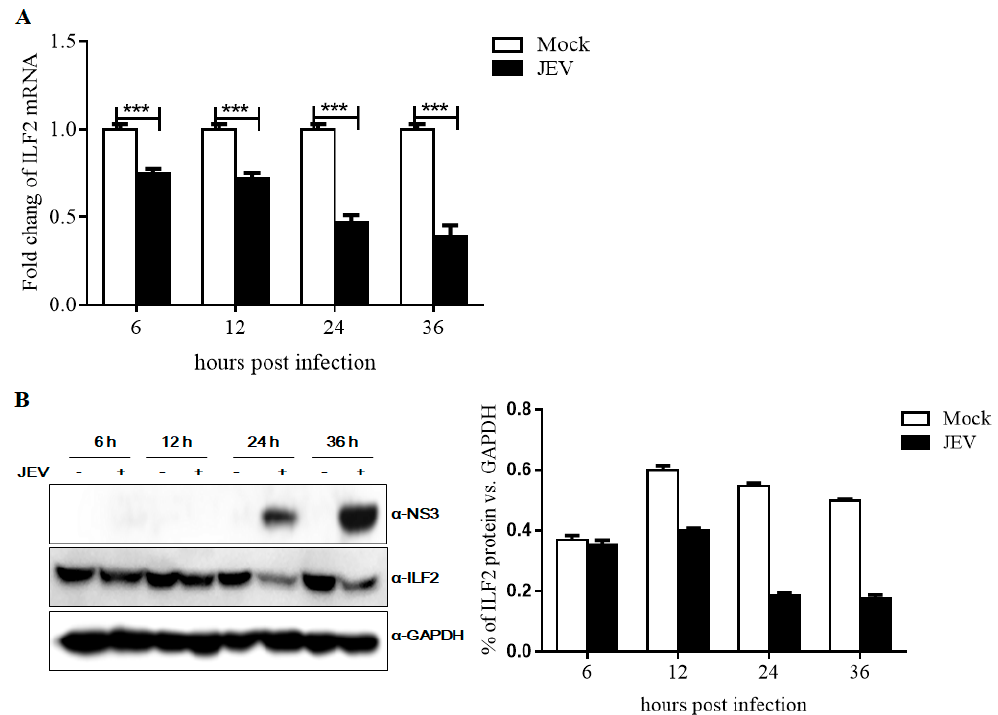
Figure 4. Expression of ILF2 in 293T cells infected with JEV. ( A ) 293T cells were uninfected or infected with JEV at an MOI of 1.0. At different times post-infection, samples were collected and the ILF2 mRNA level was determined by quantitative real-time PCR and normalized to GAPDH. ( B ) Protein levels of ILF2 were evaluated through Western blot analysis and GAPDH was used as a normalizer (left). The relative protein levels were analyzed using Image J software (right). The data shown are from three independent assays, with the error bars representing the standard deviations (*** P < 0.001, Student’s t -test).